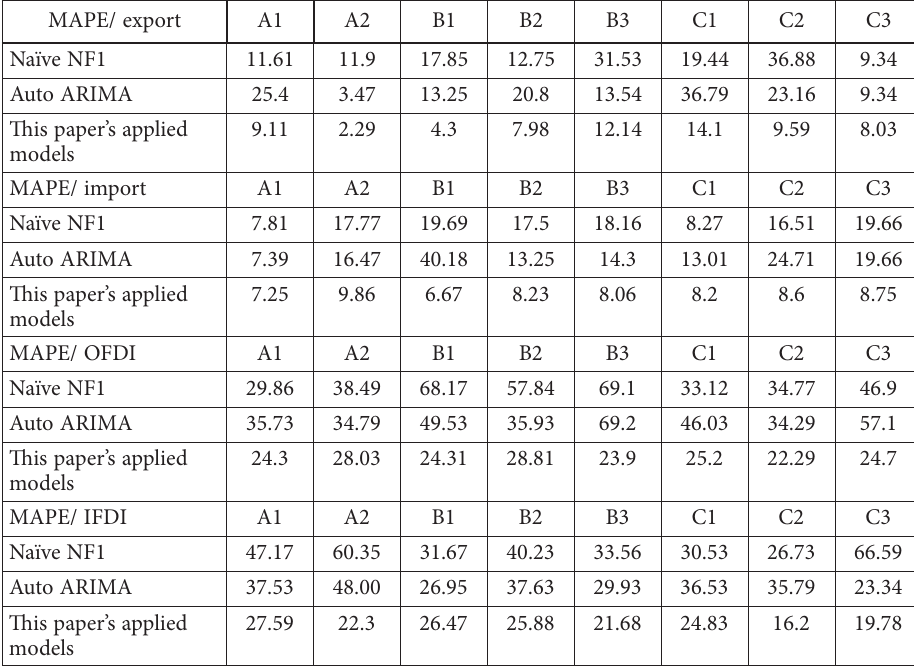
Table 2. Th e accuracy comparisons of forecasting models (source: compiled by the